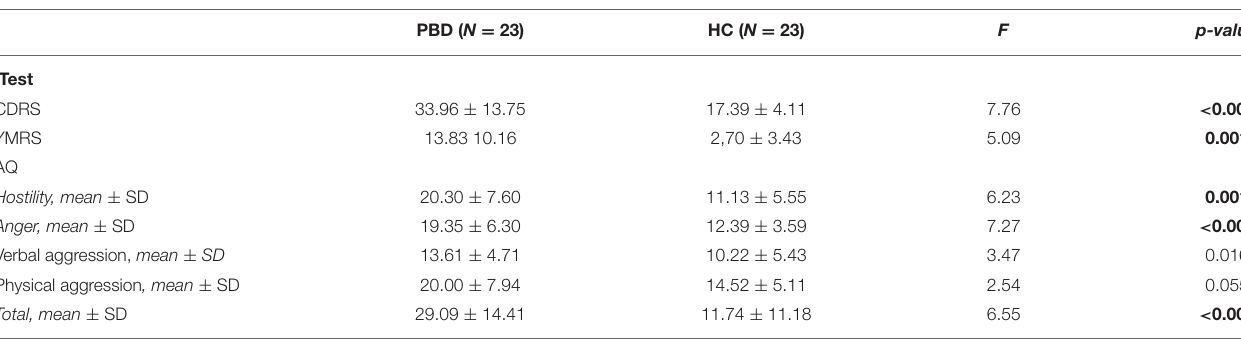
TABLE 2 | Clinical scales in youth with PBD and